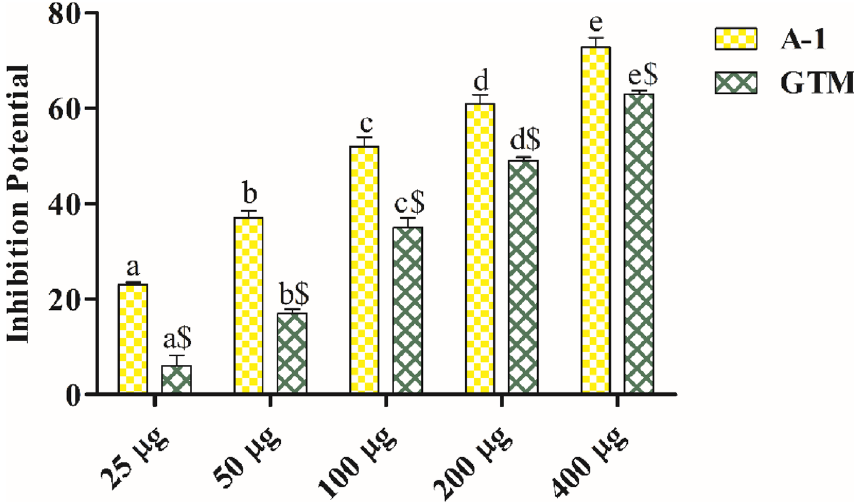
Figure 4. AChE activity of isolated compound and GTM. Data is presented as mean ± SEM. GTM G. tiliaefolia methanol extract. Data sets with different alphabets differ significantly (p < 0.05) from each other.